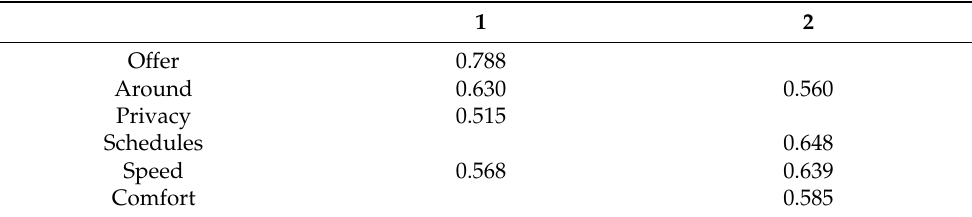
Table 6. Rotated factor matrix obtained using the extraction method of maximum likelihood and the rotation method of Varimax with Kaiser normalization, with rotation converged in 3